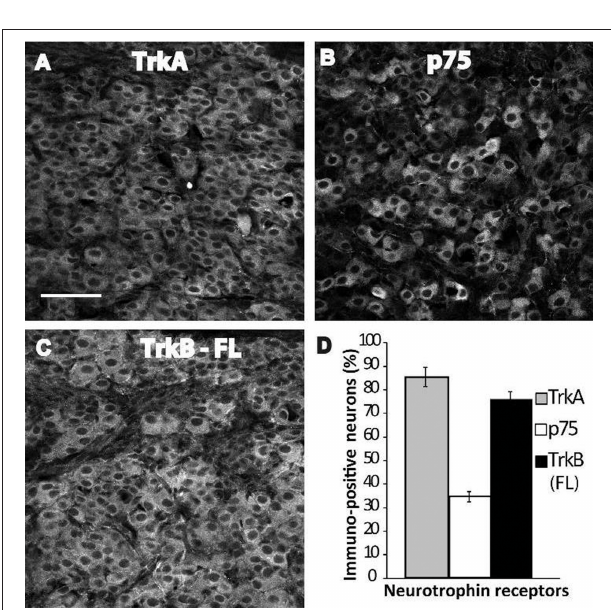
FIGURE 3 | Abundant expression of TrkB-Fl in ganglia of neonatal rats. Examples of SCG neurons from early postnatal pups (day 4–6) immunolabeled against TrkA (A) , p75NTR (B) , and TrkB-Fl (C) . Sampling across the entire ganglion resulted in different proportions of immunopositive neurons; 86% of the neurons expressed TrkA, 35% expressed p75NTR, and 76% expressed TrkB-Fl (D) . Scale bar = 100 µ m, n = 3. 3%, respectively), as well as abundant expression of